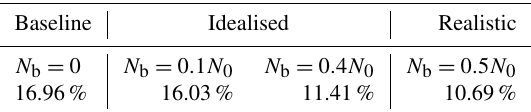
Table 6. Canyon-averaged RD ALL for NG-B and different back- ground cases. Note that the baseline concentration ( N b = 0) is iden- tical for idealised and realistic